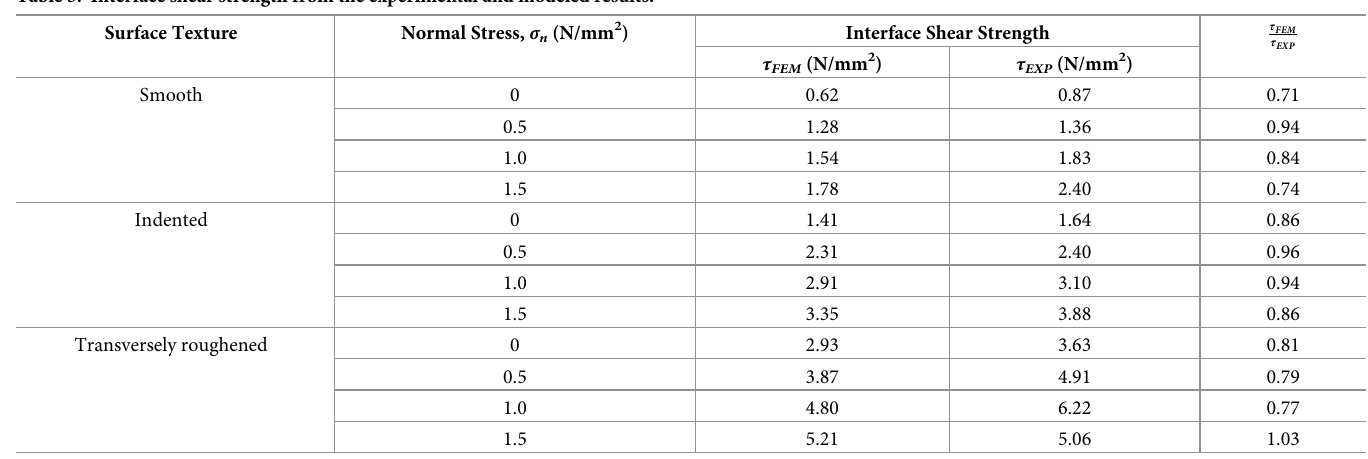
Table 3. Interface shear strength from the experimental and modeled results. Surface